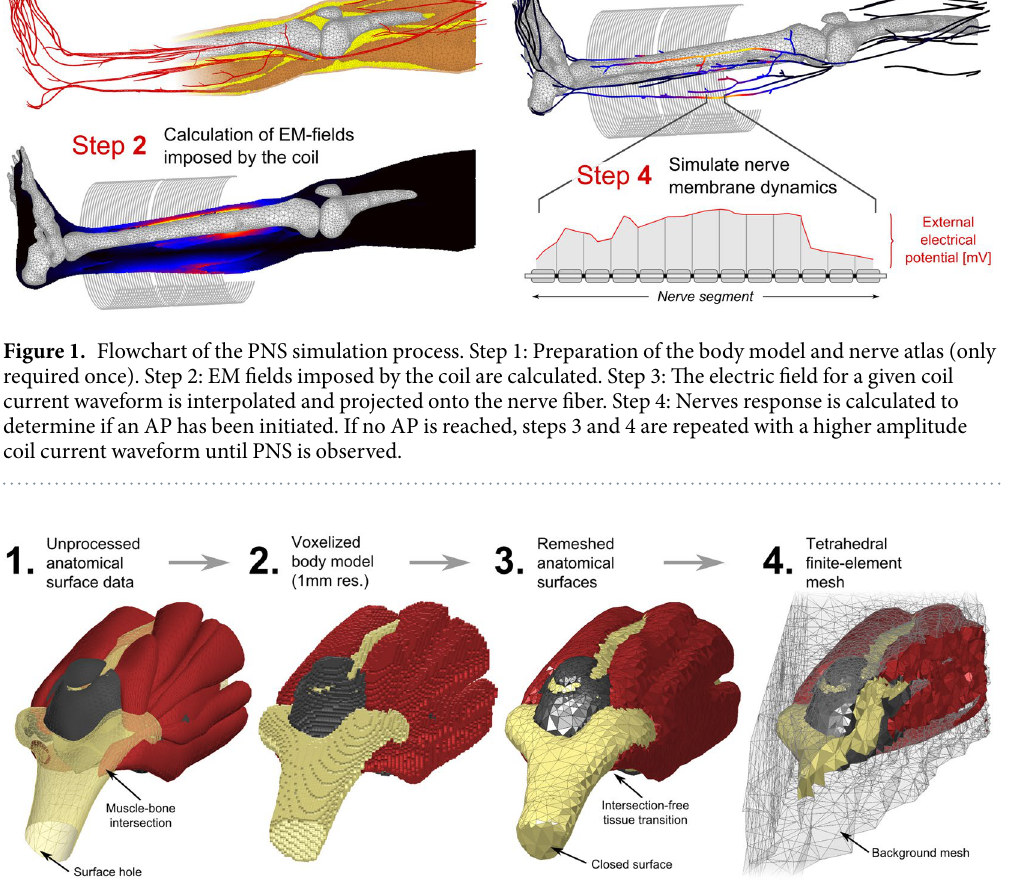
Figure 2. Processing pipeline of an exemplary body model region (elbow region, including muscle, bone, articular capsule): (1) Unprocessed anatomical surface data (provided by Zygote), (2) Discretized (voxel) body model with 1mm voxel size, (3) Watertight intersection-free surfaces (obtained via segmentation of the voxel model), (4) Cross section of an exemplary tetrahedral mesh (computed using CGAL) 35 , similar to the mesh generated by CST Microwave Studio for finite-element EM field